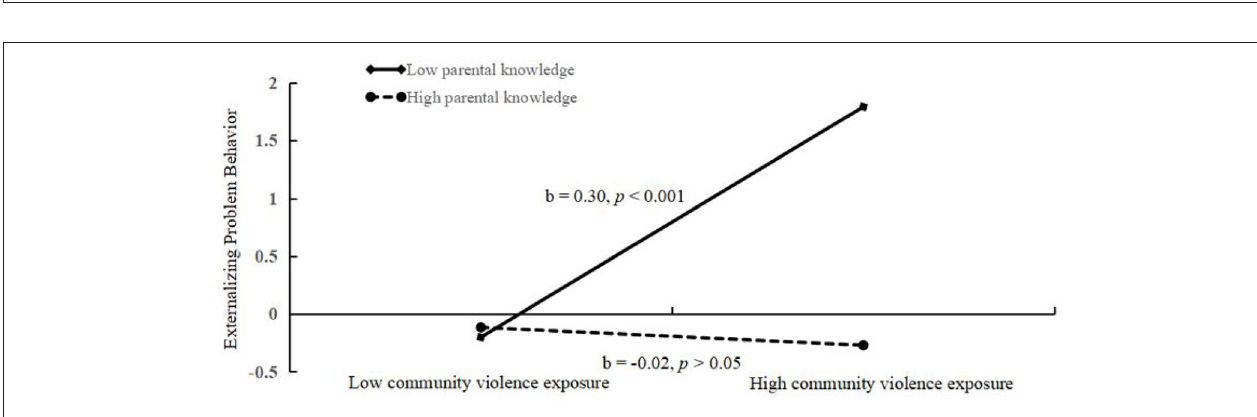
was not moderated by parental knowledge ( b = – 0.02, p